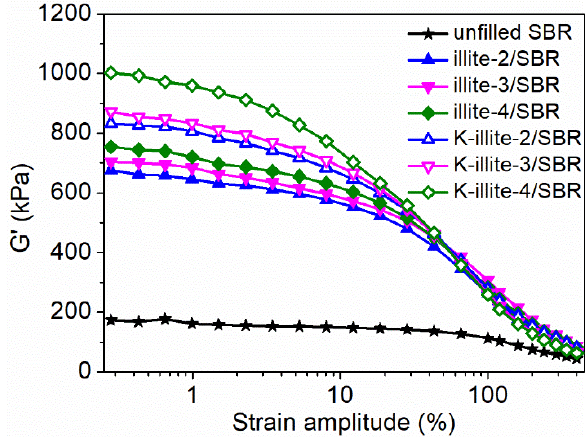
Figure 5. Strain amplitude-dependent nonlinear behavior of storage modulus (G ′ ) for SBR compounds.